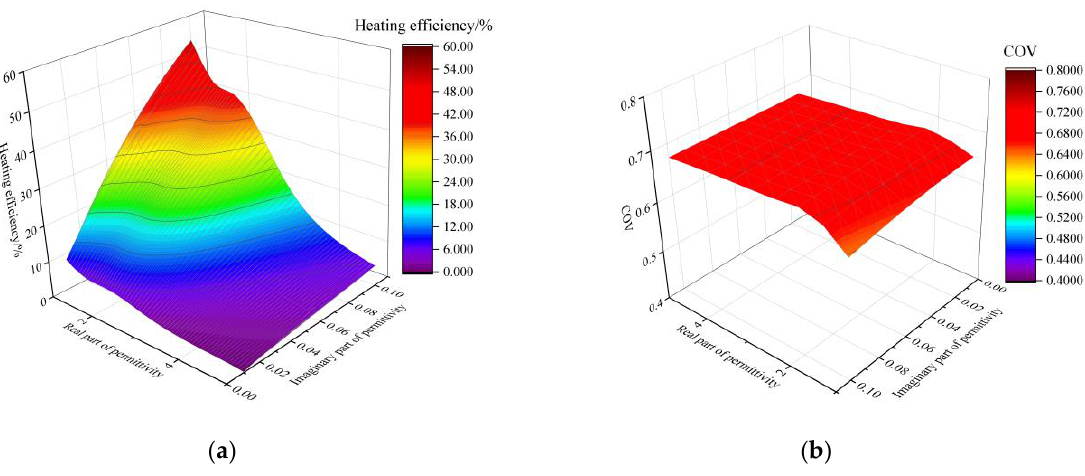
Figure 11. The 3D surface graphs. ( a ) Heating efficiency; ( b ) COV.